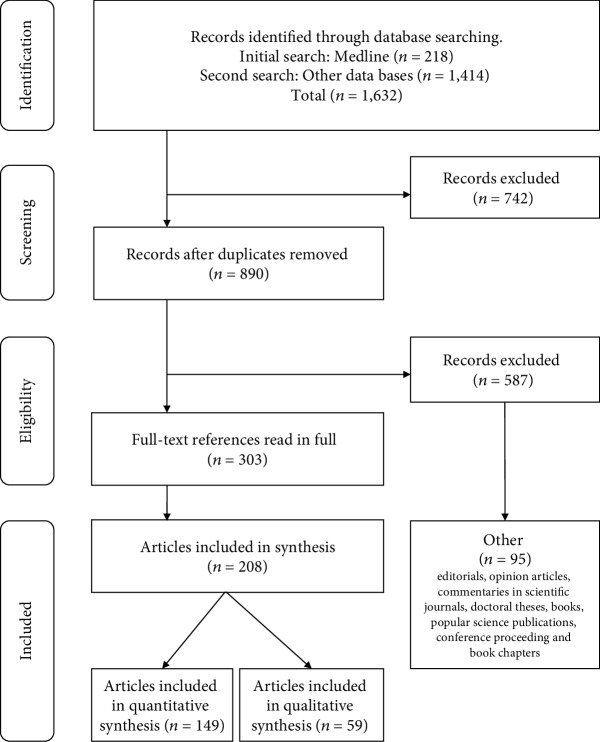
PRISMA flow diagram [15].